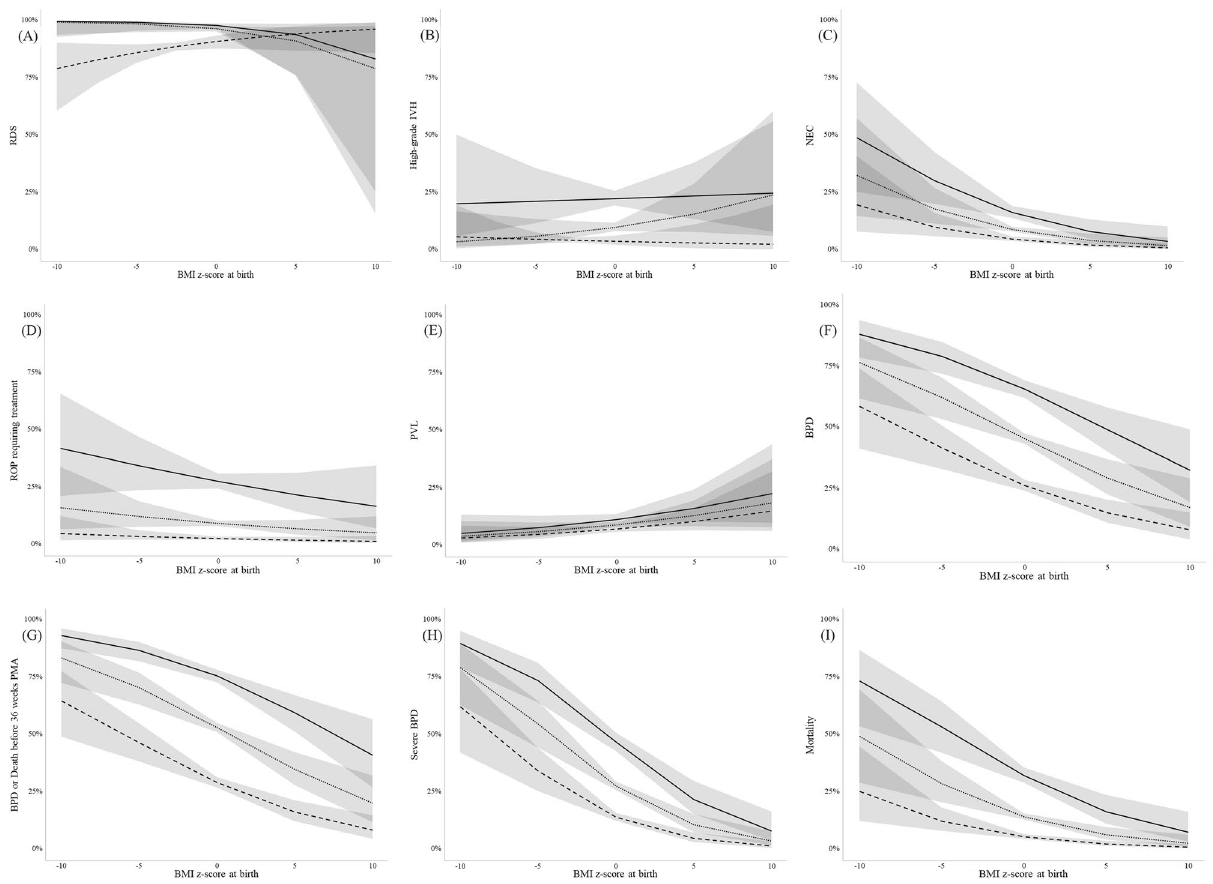
Figure 2. Predicted probability of neonatal morbidities and mortality according to BMI z-score at birth according to gestational age group. Regression lines and their 95% confidence intervals (gray shades) are shown for each gestational age group. Solid lines, 24–25 weeks gestational age group; dotted lines, 26–27 weeks gestational age group; dashed lines, 28–29 weeks gestational age group. RDS respiratory distress syndrome; BMI body mass index; IVH intraventricular hemorrhage; NEC necrotizing enterocolitis; ROP retinopathy of prematurity; PVL periventricular leukomalacia; BPD bronchopulmonary dysplasia; PMA postmenstrual age.